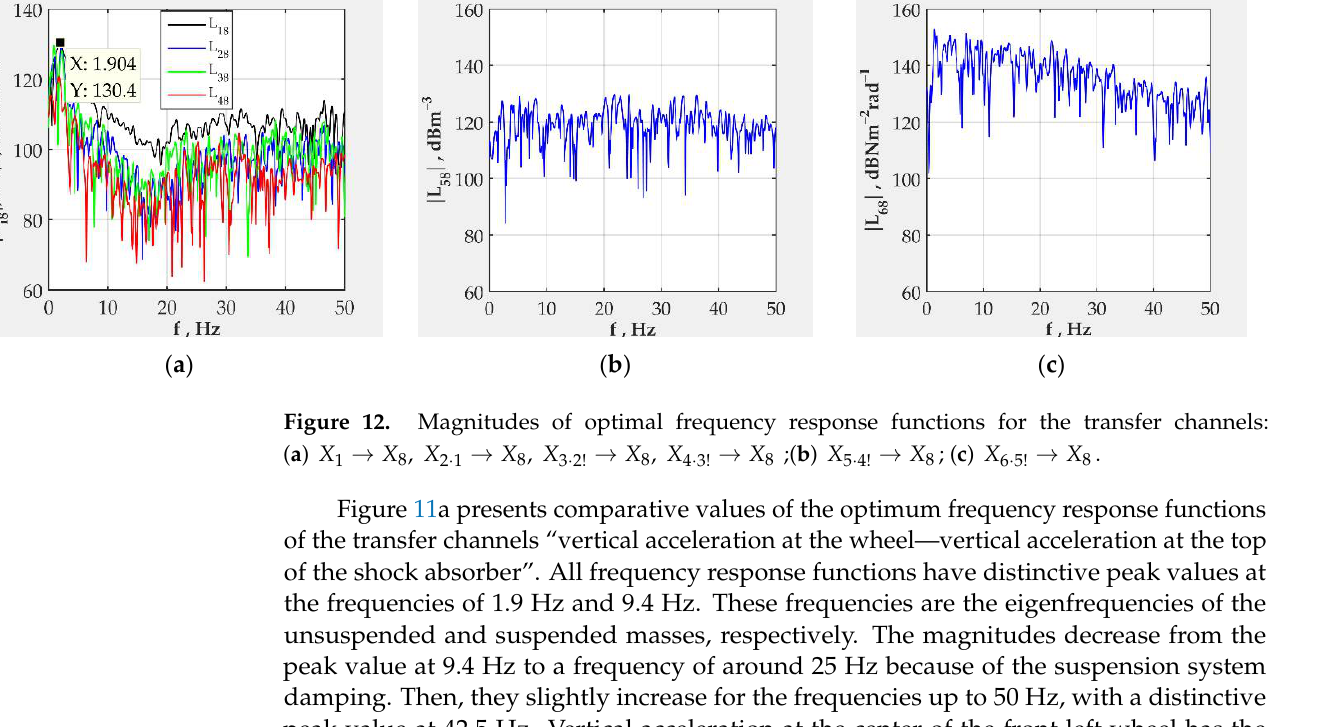
Figure 11. Magnitudes of optimal frequency response functions for the transfer channels: ( a )